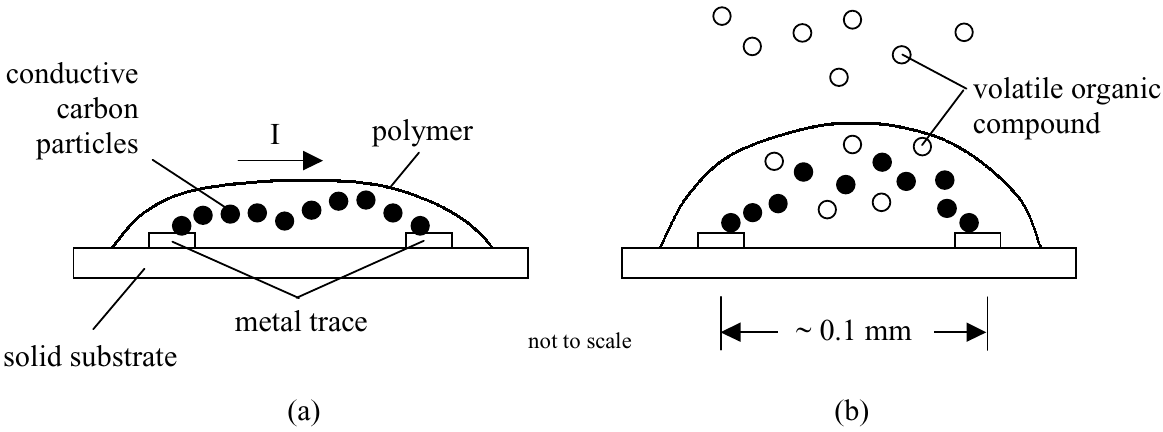
Figure 1. VOC detection by a thin-film chemiresistor: (a) Electrical current (I) flows across a conductive thin-film carbon-loaded polymer deposited on a micro-fabricated electrode; (b) VOCs absorb into the polymer, causing it to swell (reversibly) and break some of the conductive pathways, which increases the electrical resistance.